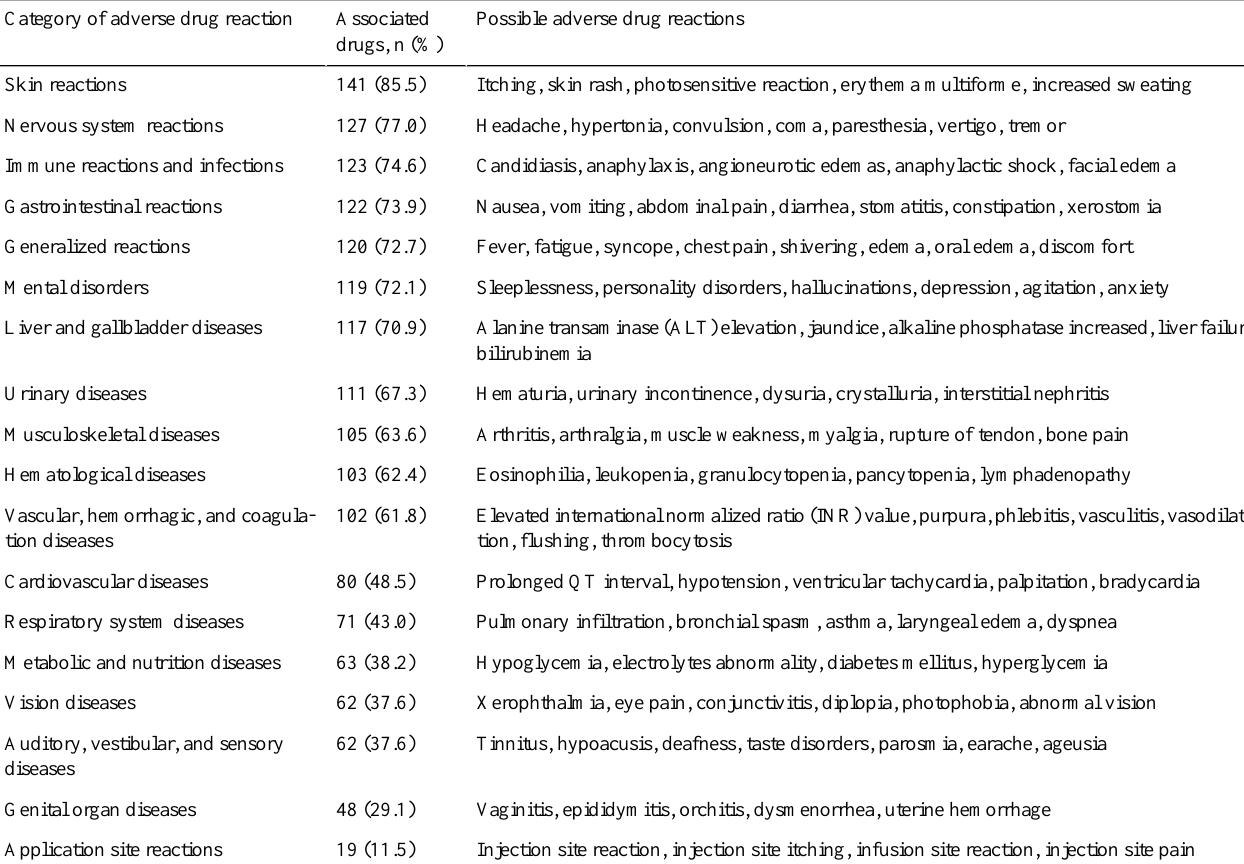
Table 3. Categorized adverse drug reactions of quinolones (N=165).